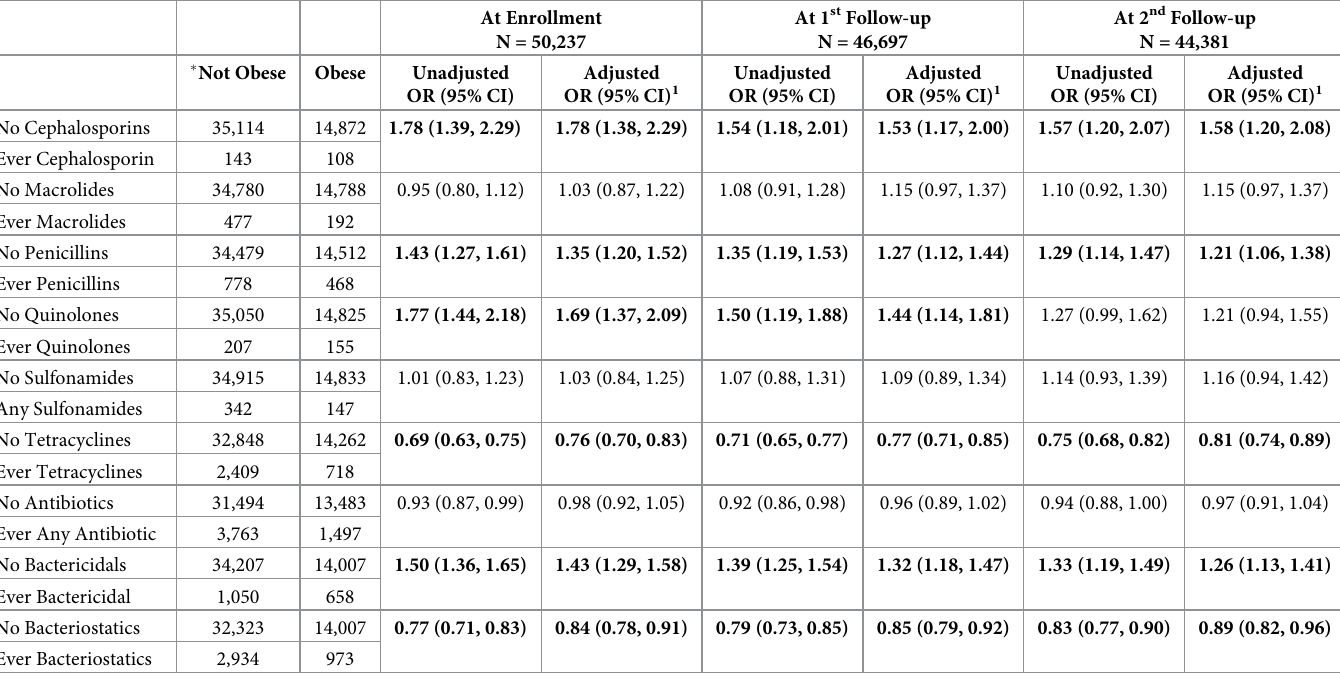
Table 2. Prevalence odds ratios of associations between antibiotic use and